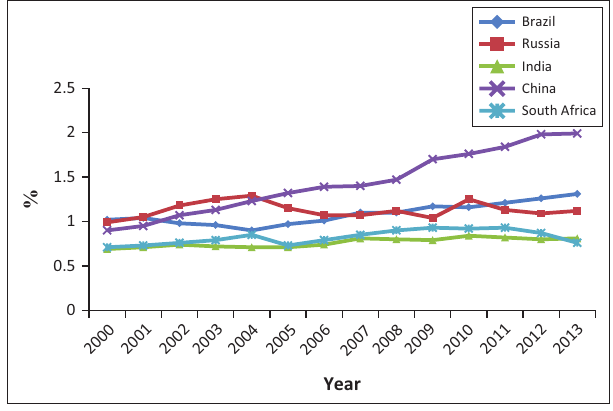
FIGURE 1: Research and development expenditure ( % of gross domestic product)